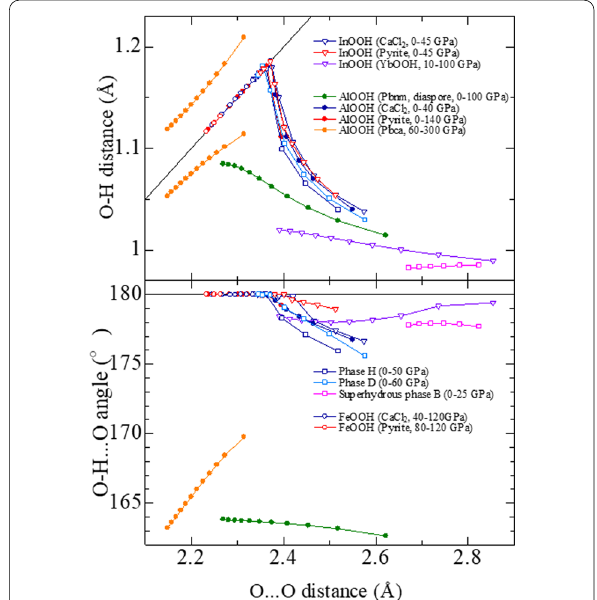
Fig. 4 The relationship between O ··· O and O–H distances (upper panel), and O ··· O distance and O– H...O angle (lower panel) of InOOH, AlOOH, FeOOH and DHMSs (Tsuchiya et al. 2002, 2005a; Tsuchiya 2013; Mookherjee and Tsuchiya 2015; Nishi et al. 2017;